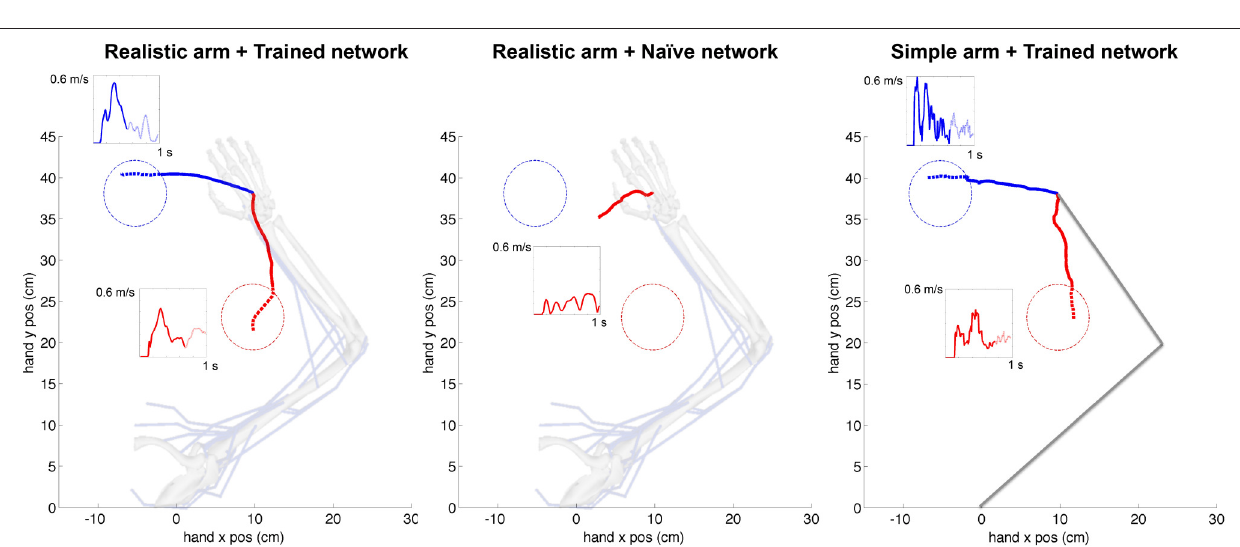
FIGURE 6 | Representative example of cartesian trajectories and velocity profiles of virtual arm during a reaching task to two targets for realistic arm and trained network (left), realistic arm and naive network (center), and simple arm and trained network (right). Trained networks employed STDP-based reinforcement learning to adapt its synaptic weights to drive the virtual arm to each of these two targets. The naive network drives the arm using the initial random weights and therefore produces random movements independent of the target location. The hand trajectories of the realistic musculoskeletal arm are smoother than those of the simple arm, and show velocity profiles consistent with physiological movement. The initial reaching trajectory from starting point to target area is shown as a solid line, whereas the final part of the trajectory within the target area is shown as a dotted line. The starting configuration of the simple and musculoskeletal arm is shown in the